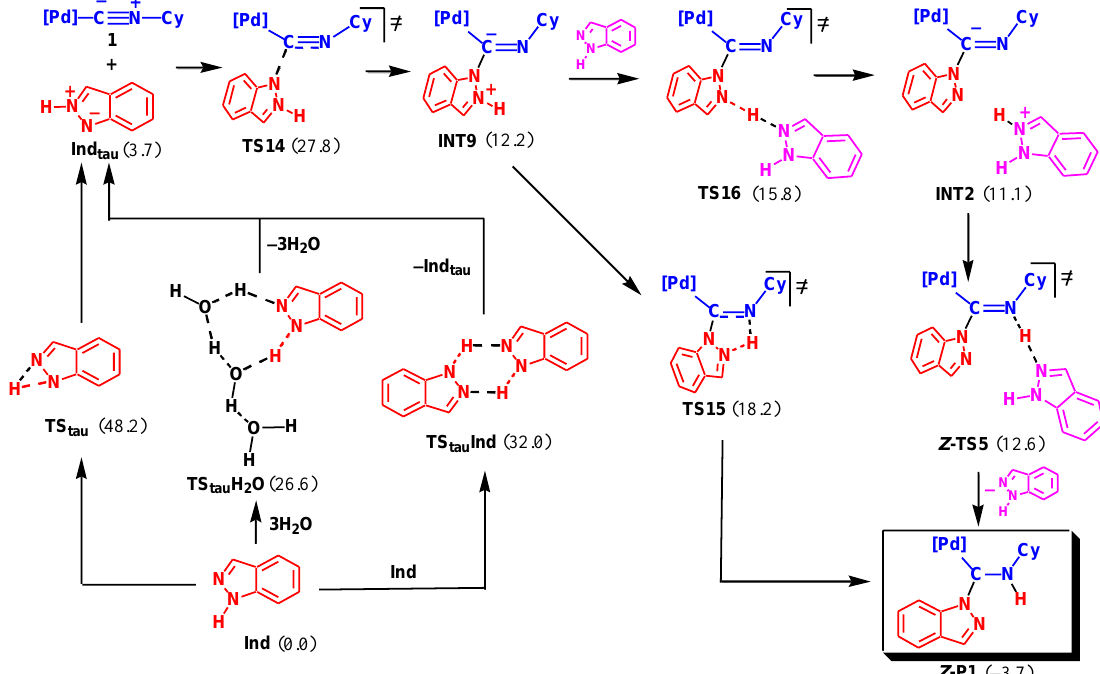
Scheme 8. Associative mechanism of NA of indazole to 1 based on the less stable tautomeric form